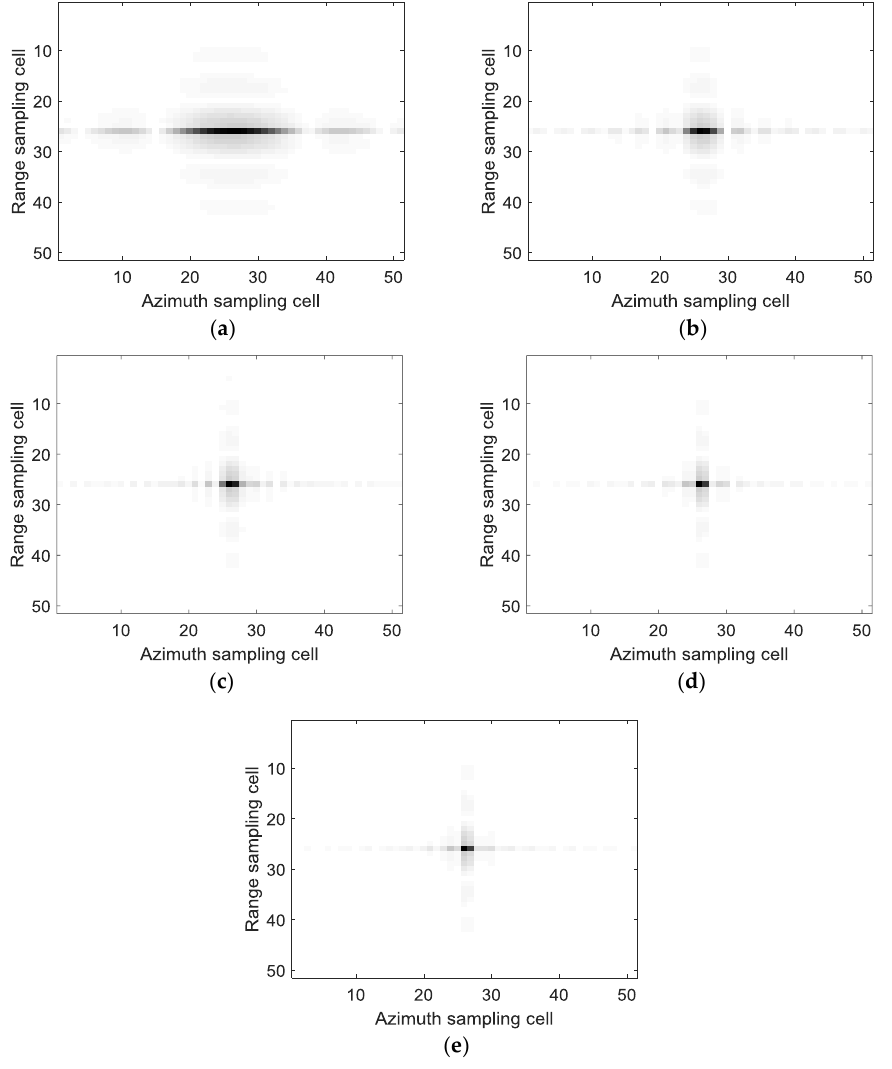
Figure 7. Imaging results after sub-aperture synthesis. ( a ) With one sub-aperture datum; ( b ) With two sub-aperture data; ( c ) With three sub-aperture data; ( d ) With four sub-aperture data; ( e ) With five sub-aperture data.